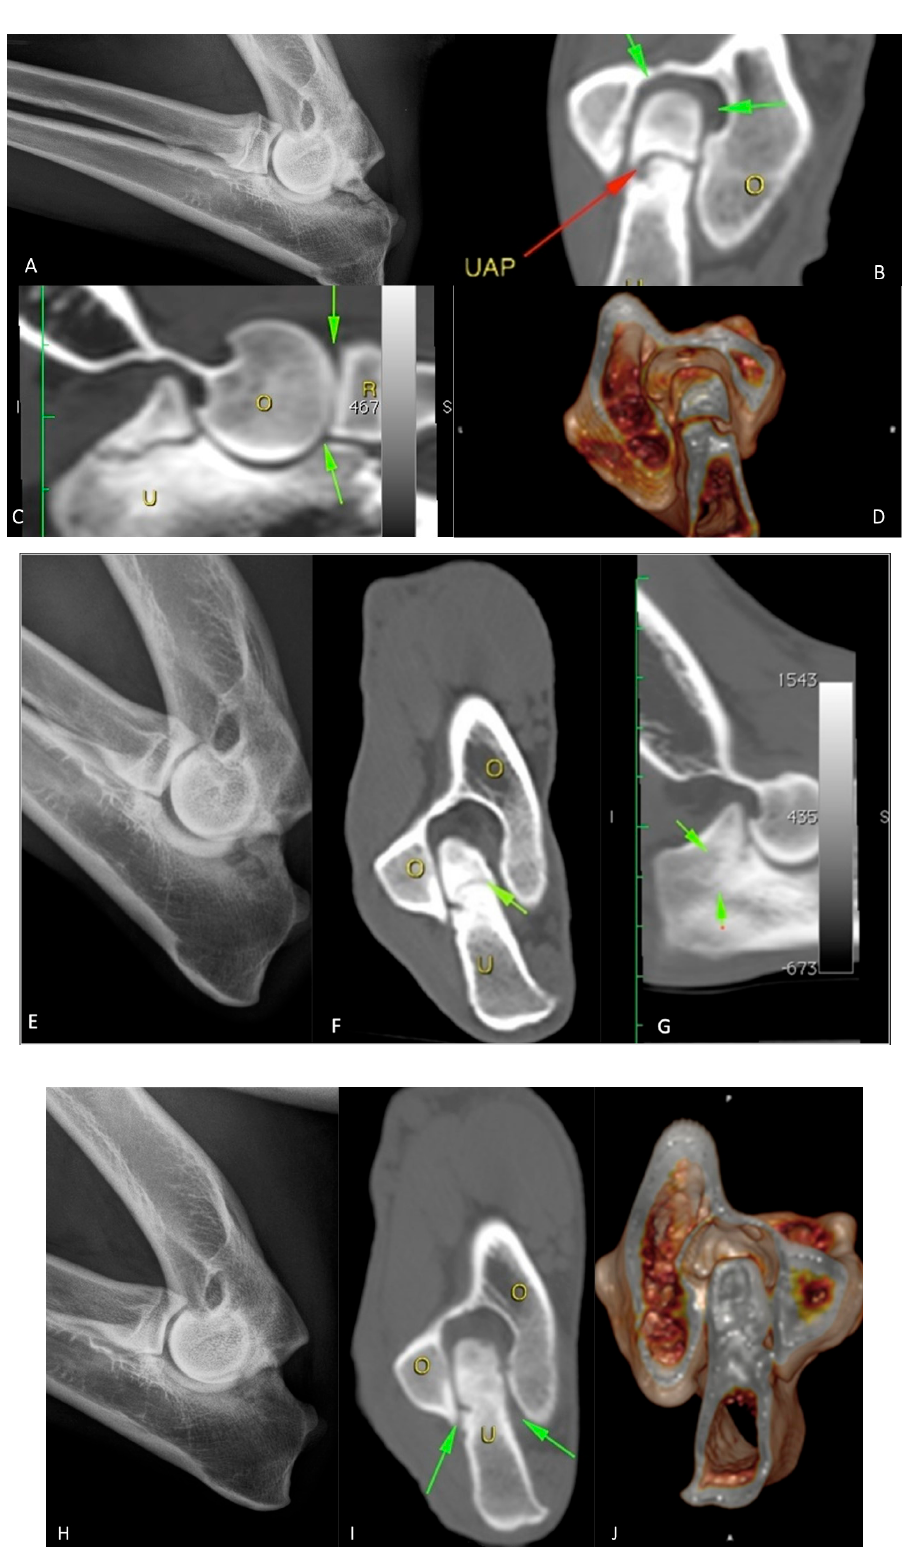
Figure 3. German shepherd female, 7 months old; grade 2 UAP. ( A – D ) Preoperative X-ray and CT exams; ( E – G ) post-operative control at 60 days; ( H – J ) post-operative control at 270 days. The ar- rows underline the anconeal process reparation. The O stands for humerus and the U stands for The O stands for humerus and the U stands for ulna.